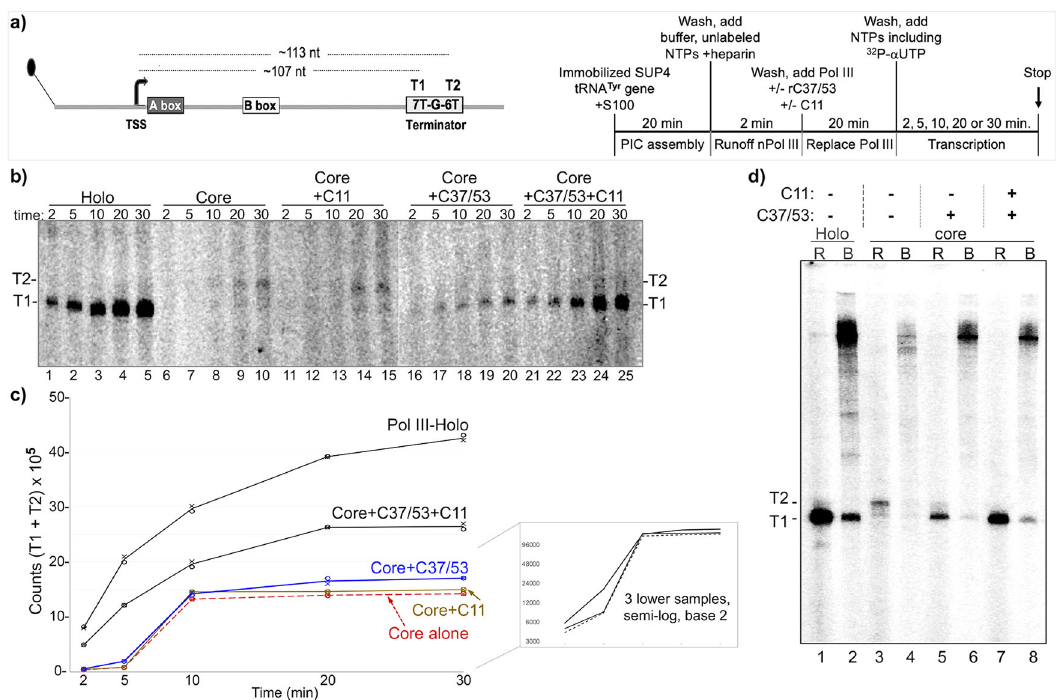
Fig. 4 C11 activates C37/53 Pol III transcription factor (TF) complexes with ef fi cient termination for reinitiation. a Left: schematic representation of the immobilized SUP4-tRNA Tyr gene with A-box, B-box promoter elements, and T1 and T2 terminators indicated, that is used to form transcription preinitiation complexes (PICs) described in the text and in Supplementary Fig. 2. Right: schematic description of the PIC assembly and transcription time-course reactions shown in ( b ); NTPs nucleoside triphosphates. b RNA products of in vitro transcription reactions carried out on a batch of SUP4-tRNA Tyr transcription complexes reconstituted with either Pol III-holo (lanes 1 – 5, numbered below), Pol III-core (lanes 6 – 10), or Pol III-core preincubated with C11 only (core + C11), C37/53 only, or C37/53 + C11 subunits (lanes 11 – 15, 16 – 20, and 21 – 25). All lanes were part of the same transcription experiment and were run on the same gel. Lanes 15 and 16 were separated by empty lanes but were juxtaposed in the image shown as indicated by the vertical line. In this gel system, the T1 and T2 bands correspond to sizes ~107 and ~113 nucleotides (nt), respectively, as illustrated in panel a and annotated on the left side of panel b (see Supplementary Fig. 2b). c The amounts of T1 + T2 RNAs at each time point in b were quanti fi ed and calculated with Multigauge V3.2 software 39 . Two data points for each time point represent independent duplicate biological replicates for the same batch of construct proteins. The means of the two points were used to plot the lines for the sets of proteins as annotated. The blue and red lines were used for visual contrast. The inset shows only the lower three time-course plots on a semi-log scale, base 2. Regression analysis of the quanti fi ed data with R 2 values is shown in Supplementary Fig. 3. d Release of RNA at the T1 terminator is not suf fi cient for ef fi cient recycling by Pol III-core. The RNA products of an in vitro transcription reaction as in panel b (30 min.) were separated into released (R) and bound (B), prior to examination by denaturing gel electrophoresis; the T1 and T2 bands are as in panels a and b , corresponding to ~107 and ~113 nucleotides (nt) in